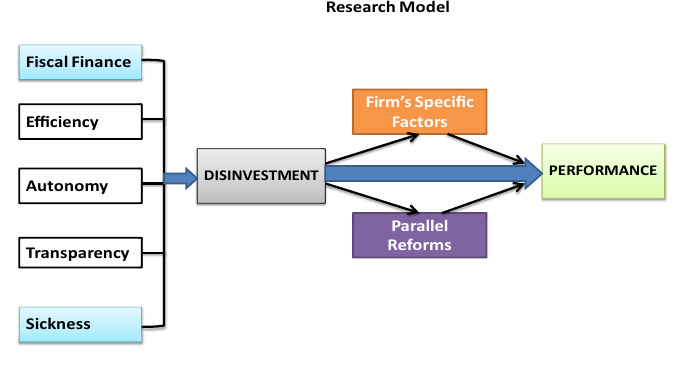
Figure 1. Conceptual